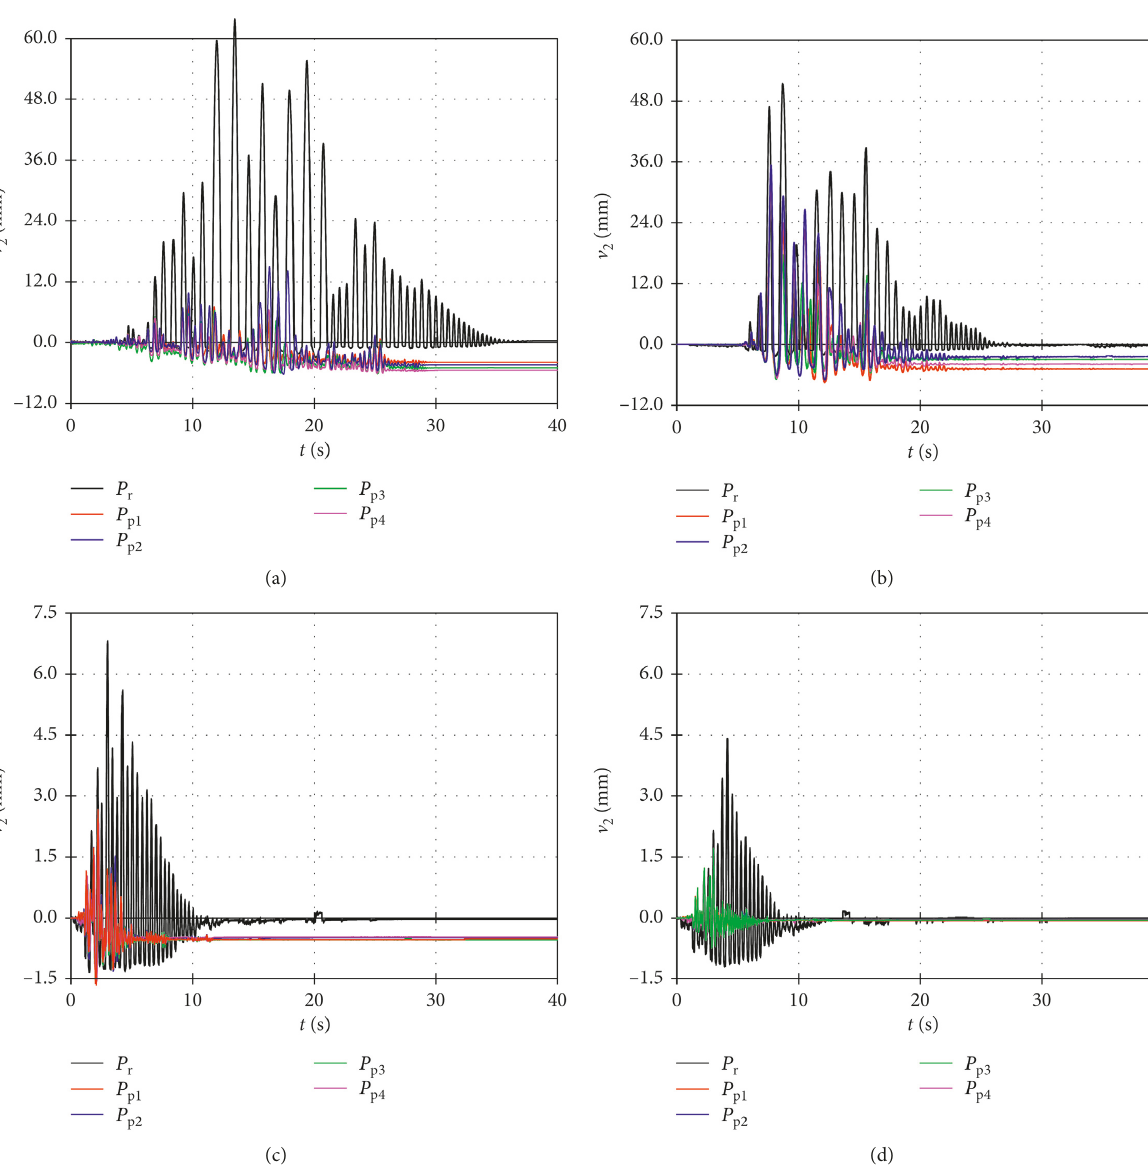
) for MSB. (a) Artificial accelerogram (AA). (b) Accelerogram 2